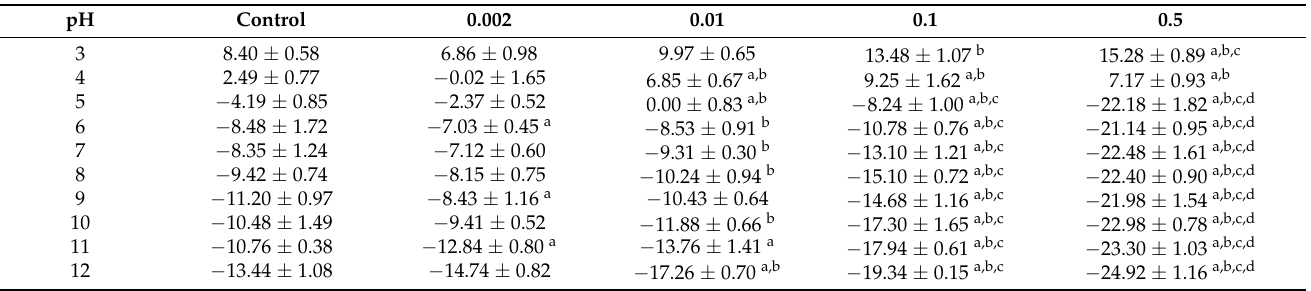
Table 3. The zeta potential of the platelets’ cell membranes after exposure to PS-NH 2 -200 (C = 0.002, 0.01, 0.1, and 0.5